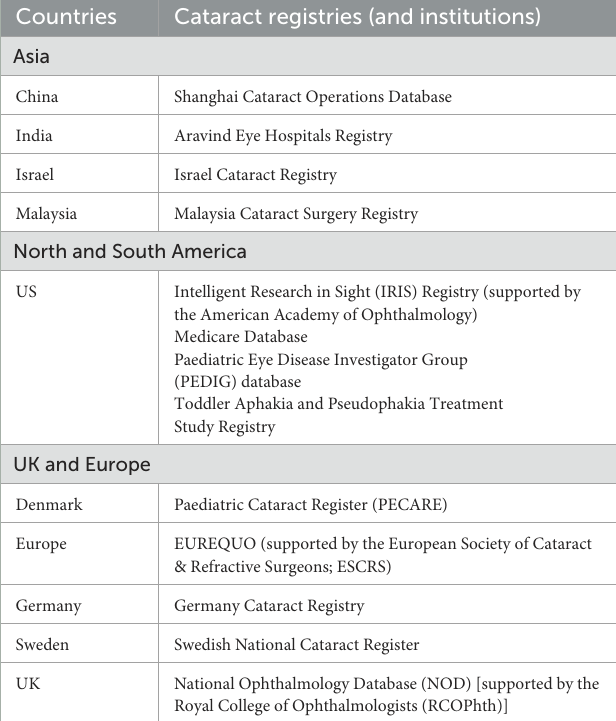
TABLE 3 Summary of main cataract registries in the world, categorized by continents.